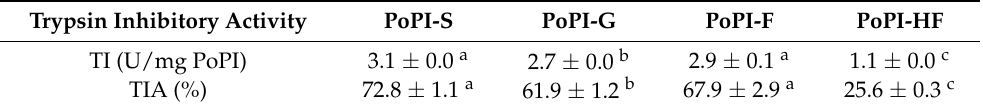
Table 1. Trypsin Inhibitory Activity (TIA, Units/mg solids) and percentage of inhibition (TIA%) (see methods) for various treatments. One unit of TIA produced 50% inhibition of 2 Trypsin units. Values are reported as the average of three replicates with standard deviation. Different letters indicate statistically significant differences between